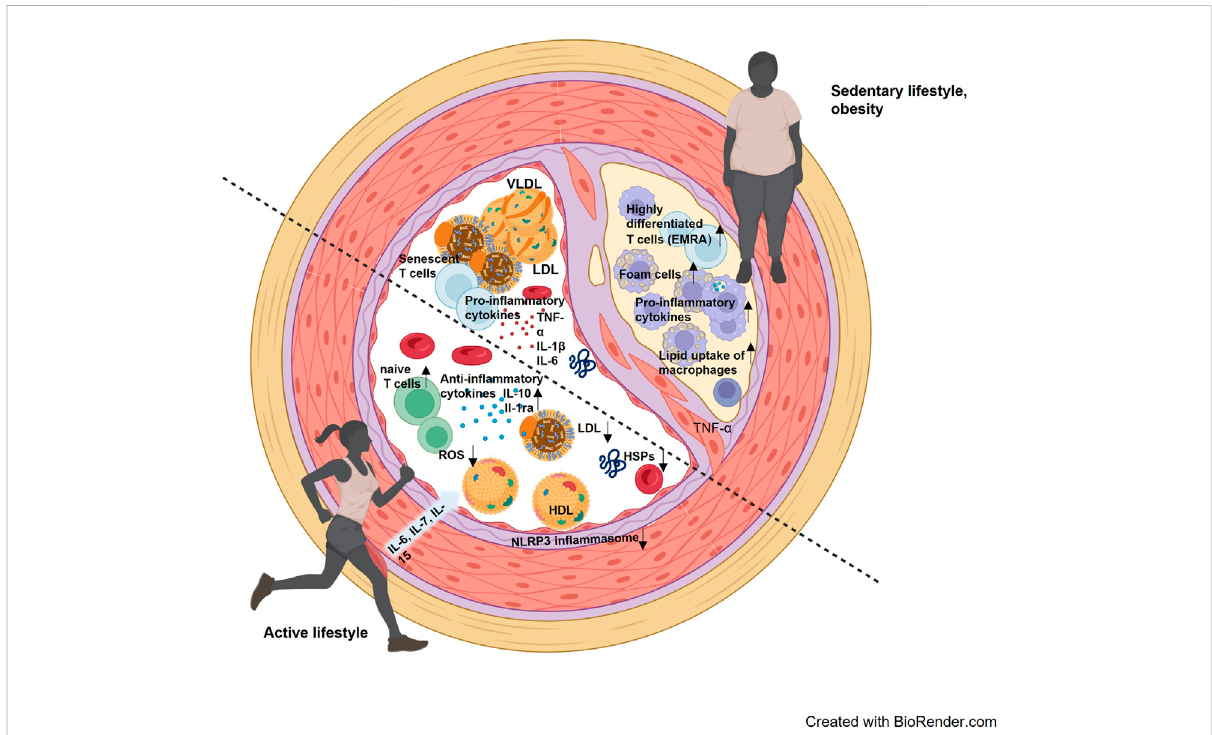
Interaction of blood lipids, cellular and molecular components of the immune system and stress proteins in an inactive lifestyle and an active lifestyle. The lower left half of the vessel visualizes the consequences of an active lifestyle, where reactive oxygen species (ROS) are effectively reduced, a more anti-in fl ammatory environment prevails, and blood lipids are present with a rather low LDL and higher HDL. The contrast is the upperrighthalf ofthevessel, where amoreproin fl ammatoryenvironmentprevails,with higher LDL levels andaccumulated senescentcells. An arteriosclerotic plaque has also already formed here, containing foam cells and in fi ltrated by more in fl ammatory leukocyte